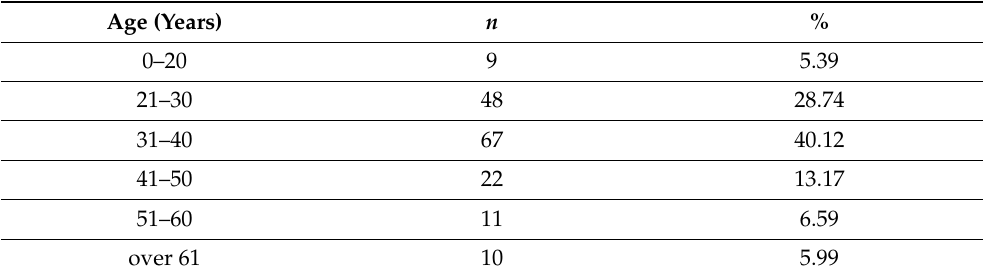
Table 1. Distribution of new HIV/AIDS cases by age.